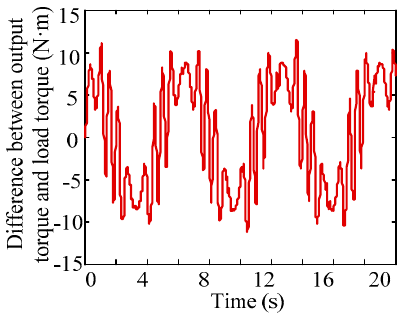
Figure 13. The curve of the load torque matching difference.